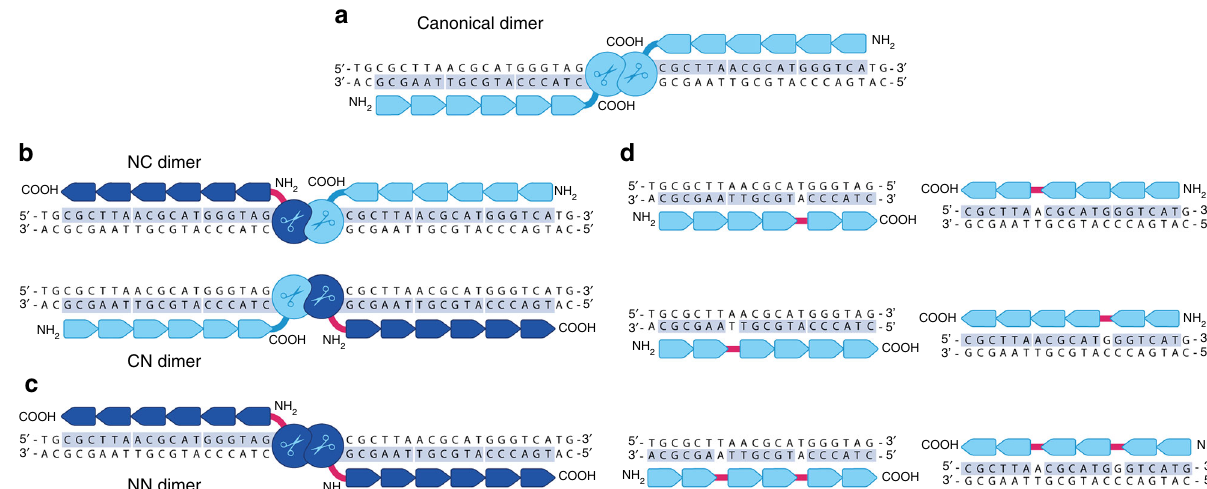
Fig. 1 Linkers and architectures developed in this study. a Sketch of the canonical ZFN dimer architecture. Circles marked with a scissors symbol denote the FokI cleavage domain. A tandem array of six arrows indicates each designed six- fi nger ZFP. Key features of this architecture include attachment of the FokI nuclease domain to the carboxy terminus of each zinc fi nger array and a lack of base-skipping between adjacent zinc fi ngers. ZFNs are shown interacting with duplex DNA, with black text on a gray background denoting ZFN target sites. b Alternative architectures enabled via pairing of ZFNs bearing an amino-terminal FokI cleavage domain (dark blue) and a carboxy-terminal FokI cleavage domain (light blue). The linker joining the FokI nuclease domain to the amino terminus of the ZFP is shown in red. ZFNs bearing an amino-terminal FokI attachment are able to recognize a target on the opposite DNA strand,